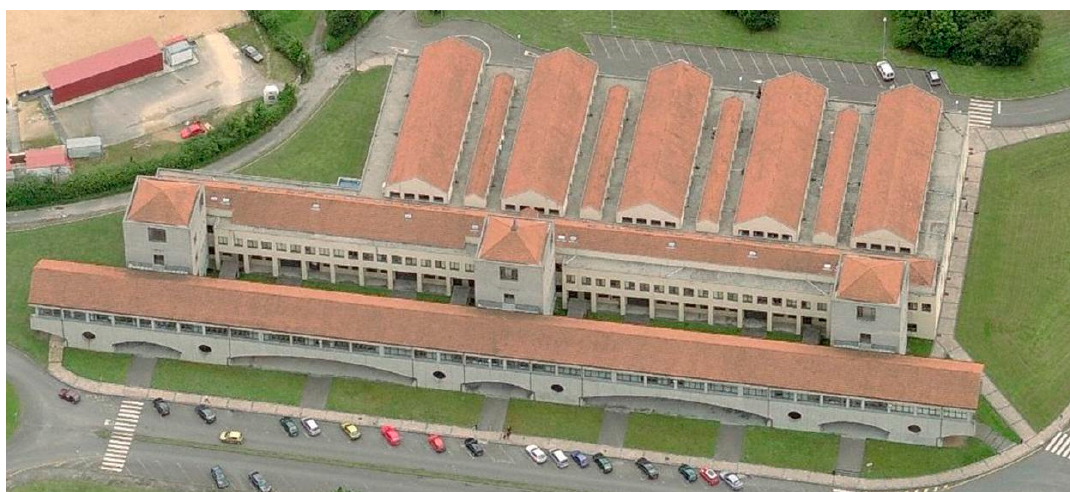
Figure 1. Energy Department Building at the Oviedo University Campus in